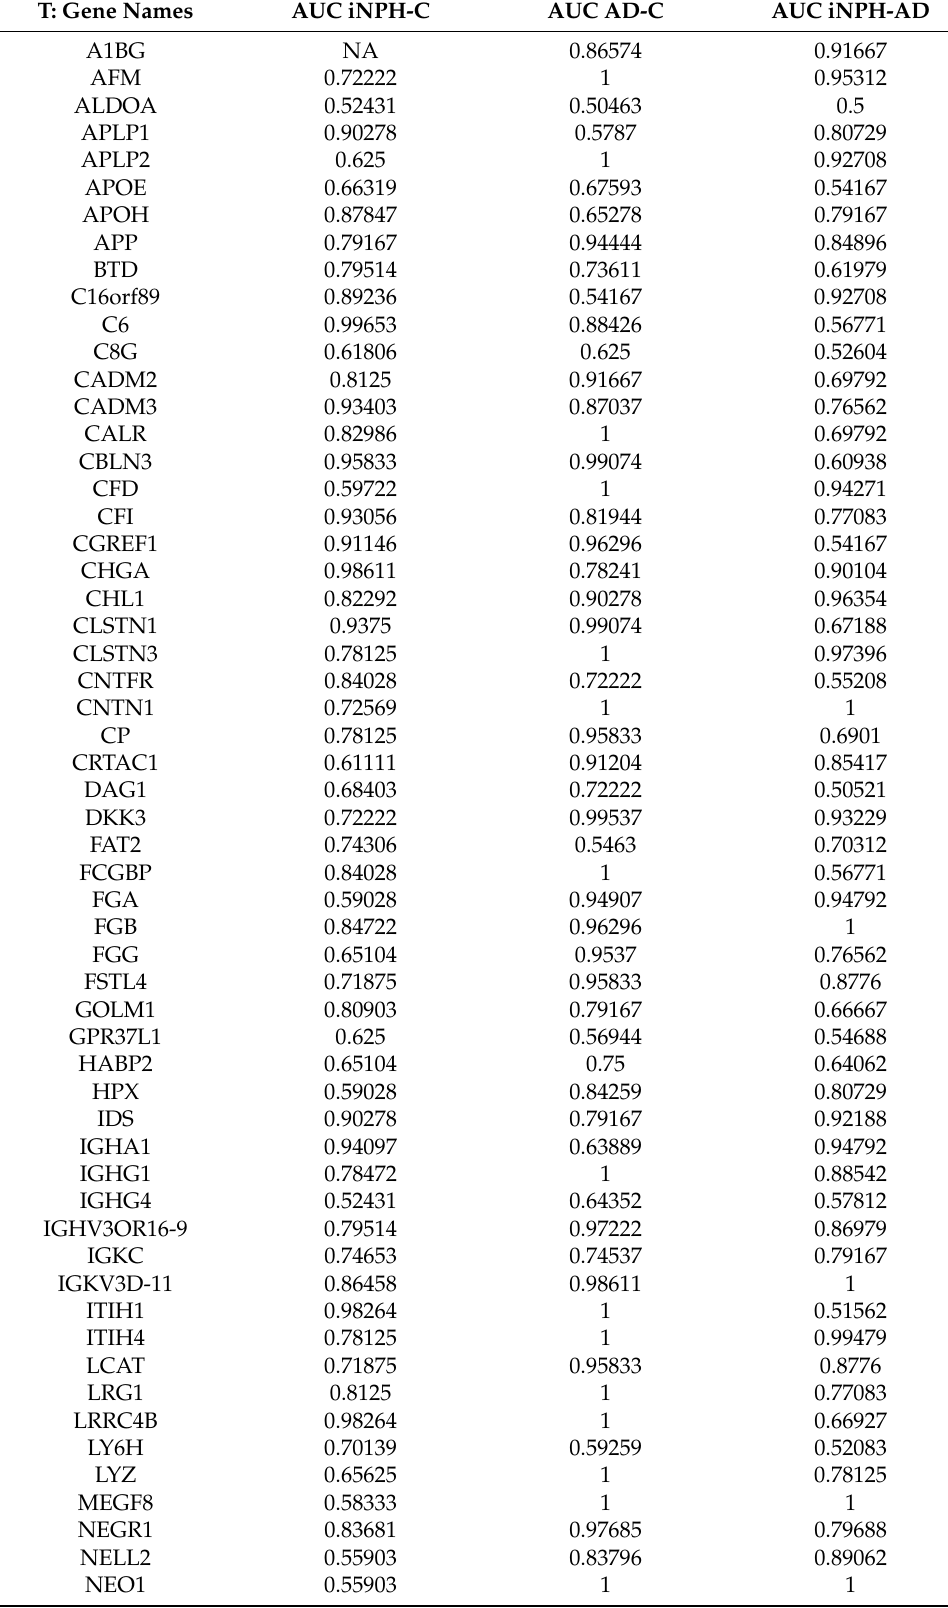
Table 3. AUC values for proteins with an opposite trend in iNPH and